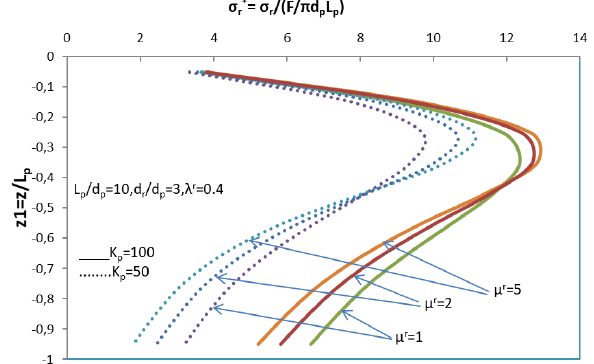
(πd L )/F, r p p =z/L – effect of stiffness factor, 1 p , of GP on a partially p /d =10, d /d =3, λ r =0.4). p p r p